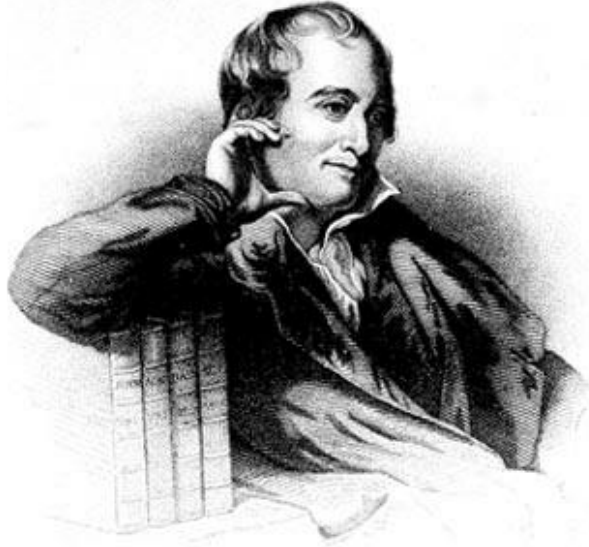
Figure 1. Portrait of William Maclure (Merrill, 1904, plate 3).